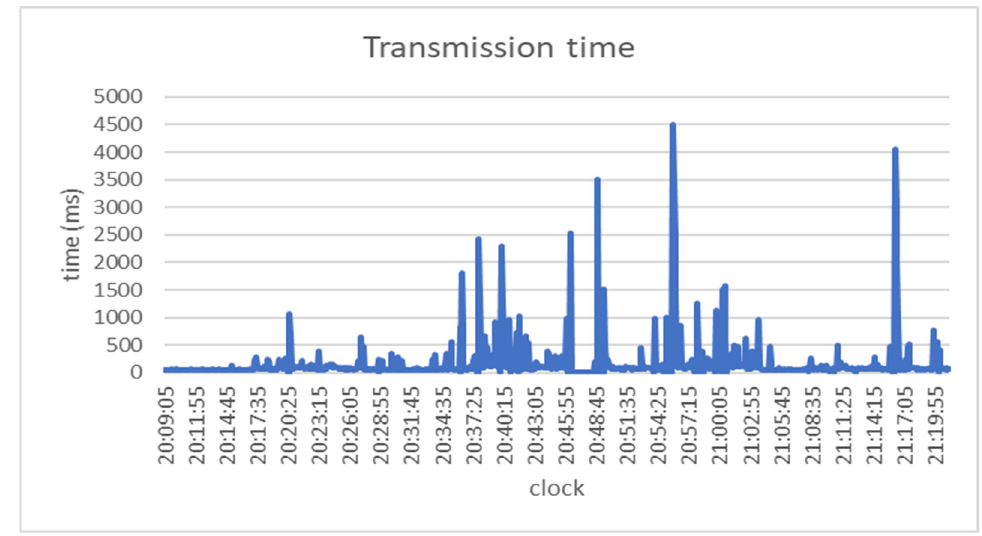
Figure 8. Transmission time.